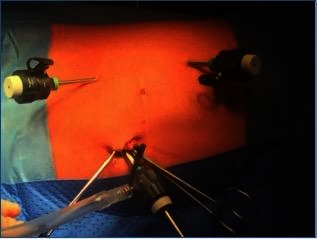
 Trocars placement.